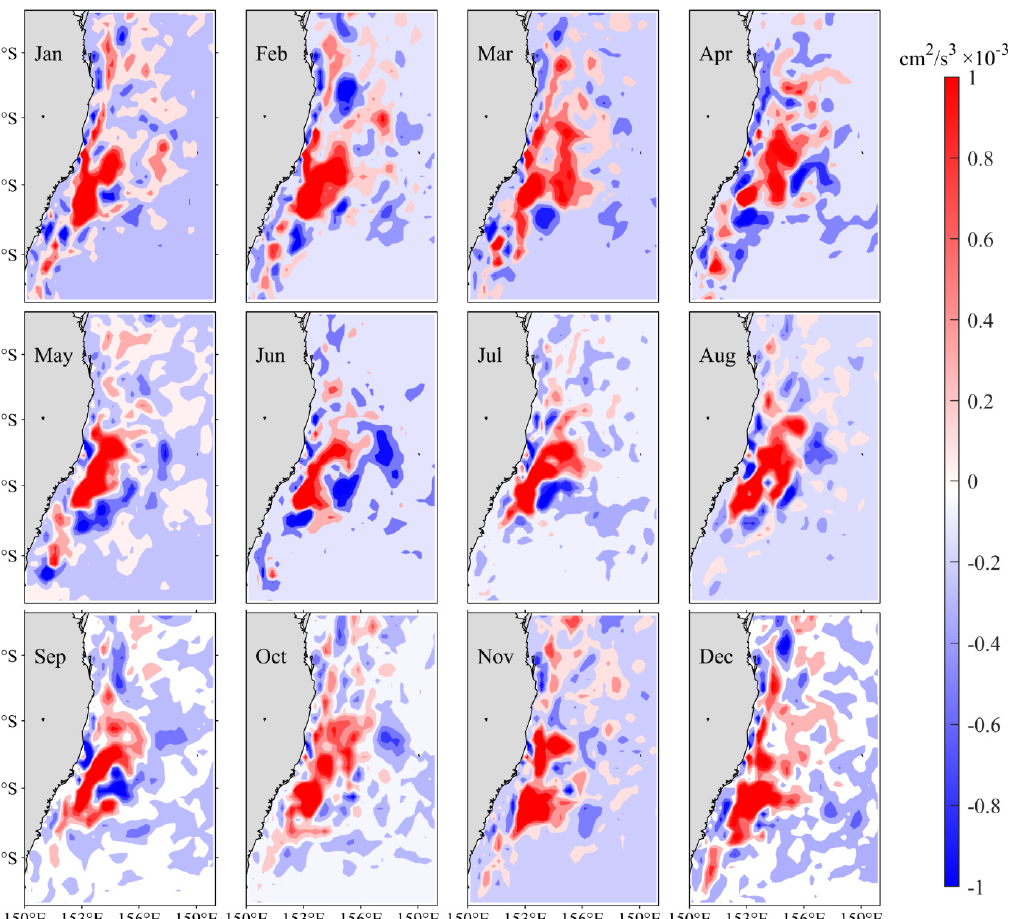
Figure 7. Monthly mean climatological barotropic conversion rate (BTR) distribution in the upper 500 m from the ECCO2. See Equation (4) for the definition of BTR. Figure 9 plots the BTR time series (red solid line) as a function of calendar months, which are averaged within 150–160° E, 25–38° S region. The BTR is largest in March (1.2 ×